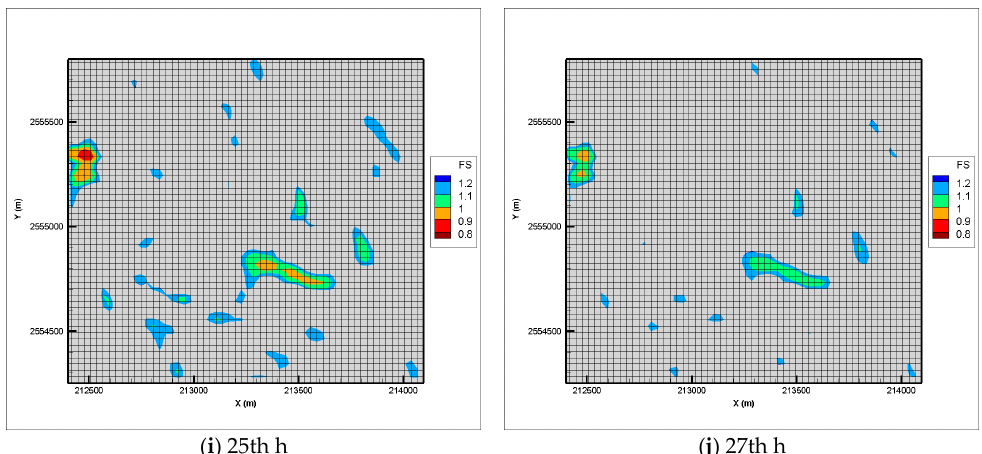
Figure 9. Simulated results of the factor of safety (FS) varying with time during the Typhoon Meigi (gray color represents FS > 1.2).